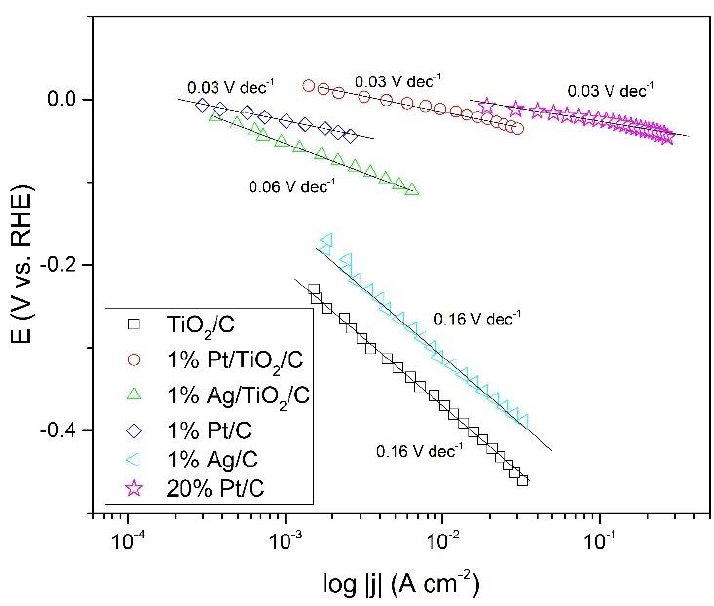
Figure 6. Comparison of Tafel plots for TiO 2 /C, 1% Pt/TiO 2 /C, 1% Ag/TiO 2 /C, 1% Pt/C, 1%, Ag/C and 20% Pt/C catalysts. The slope of the lines corresponds to 0.16 V dec − 1 , 0.03 V dec − 1 , 0.06 V dec − 1 , 0.03 V dec − 1 , 0.16 V dec − 1 and 0.03 V dec − 1 , respectively.